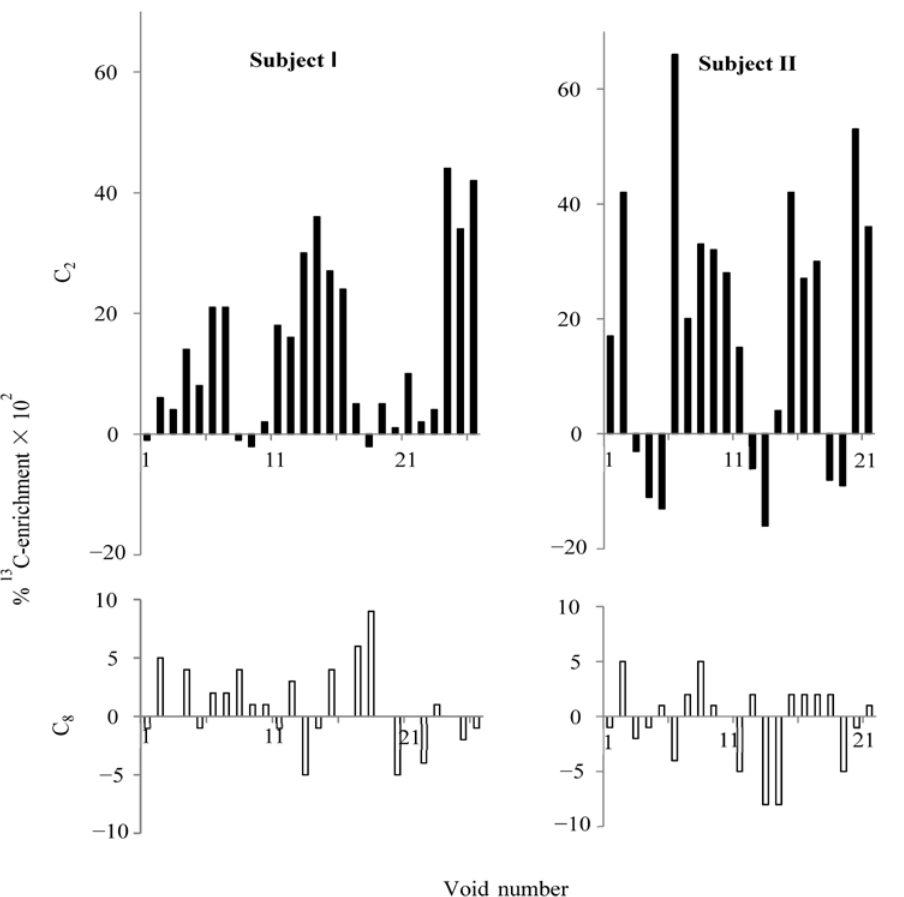
Figure 2. Percentage 13 C-enrichment at C 2 and C 8 of uric acid in urine voids after ingesting 2- 13 C-histidine. Subjects I and II had 26 and 21 urine voids, respectively. Closed bars represent percentage 13 C-enrichment at C 2 , and open bars represent percentage 13 C-enrichment at C 8